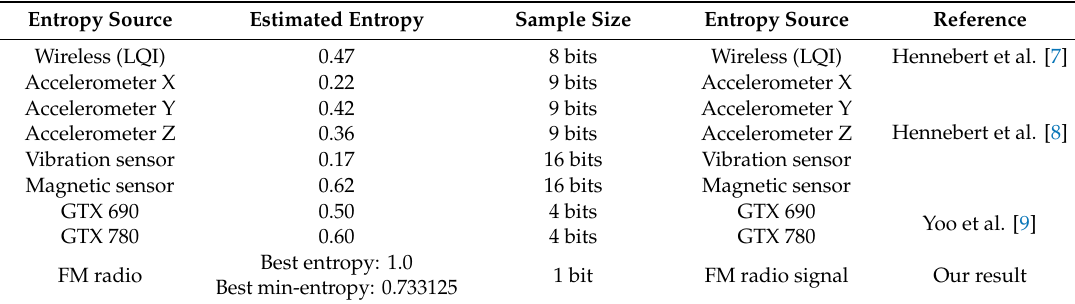
Table 4. Comparison with existing random number